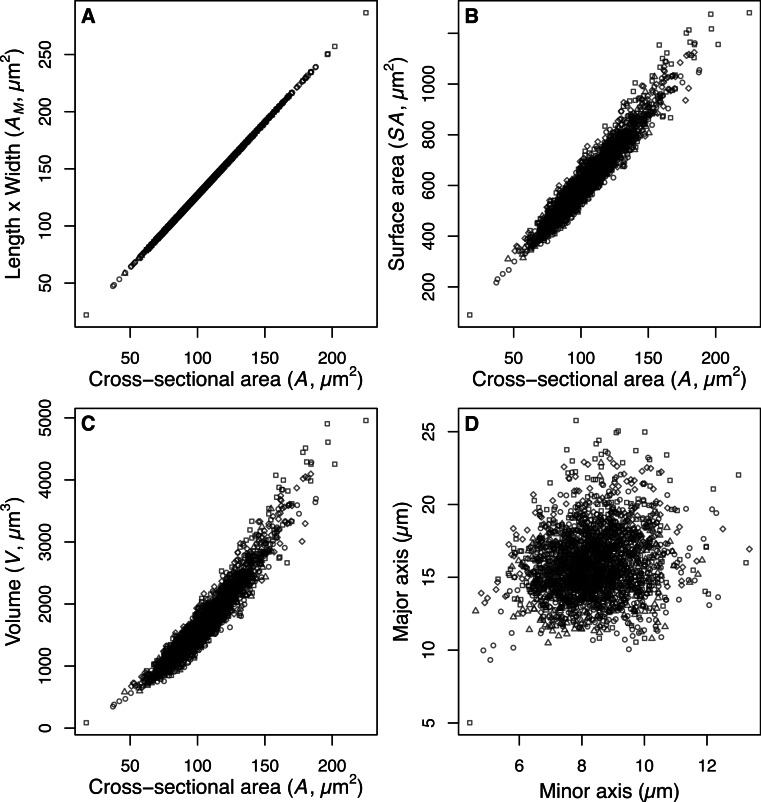
Size and shape of Aulacoseira valves.(A) Comparison of measurements of valve area (AM, µm2), (B) surface area (SA, µm2), and (C) volume (V, µm3) of Aulacoseira valves with the cross-sectional area (A, µm2) and (D) the major (diameter, W) and minor (mantle height, L) axes in valve view. Symbols for each species/variety are A. lirata var. biseriata, circle; A. lirata var. lirata, square; A. perglabra var. floriniae, diamond; A. perglabra var. perglabra, triangle.